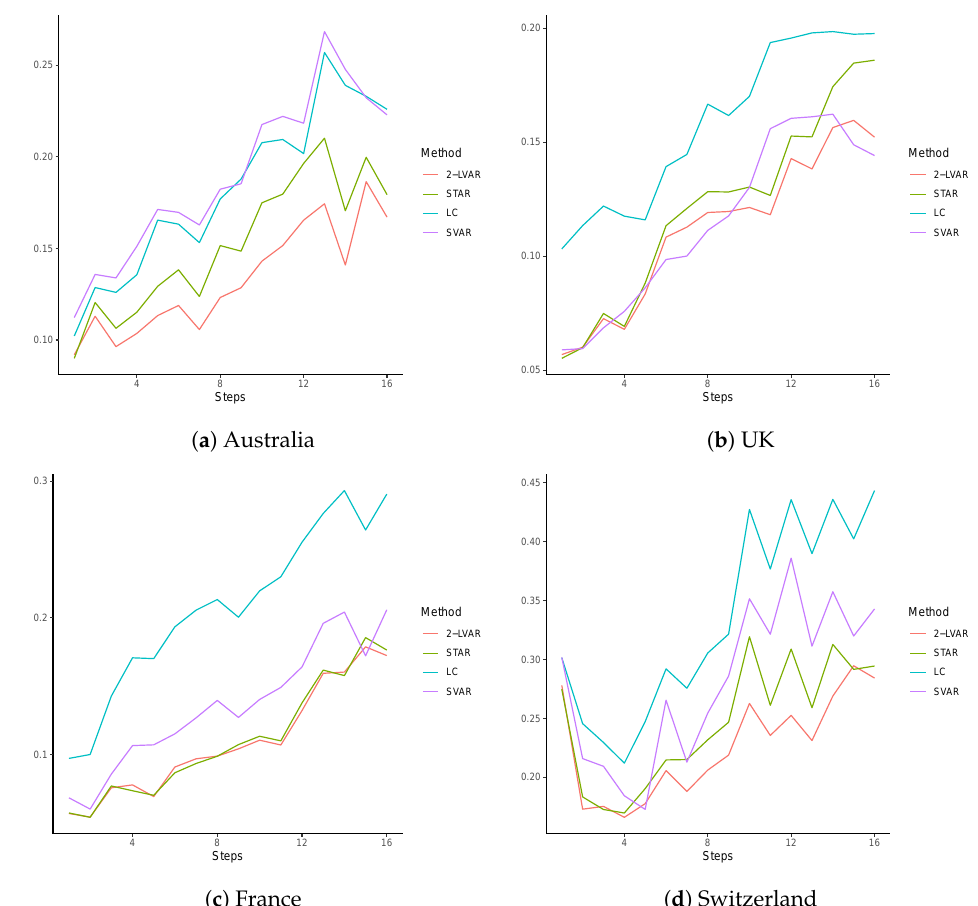
Figure 3. RMSE over forecasting steps for mortality data of Australia, the UK, France, and Switzerland. The training sample includes 1950–2000, and the test sample includes 2001–2016. The compared models are LC, STAR, SVAR, and